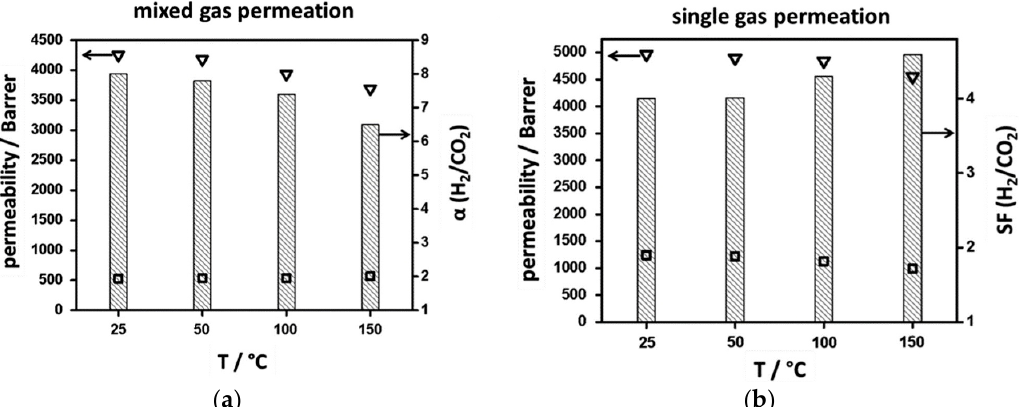
Figure 30. Mixed ( a ) and single gas permeabilities ( b ) for H 2 ( ∇ ) and CO 2 ( ⎕ ) and ideal/real separation factors (columns) for an equimolar mixture of H 2 /CO 2 at different temperatures for the neat supported NH 2 -MIL-125 membrane. (adapted with permission from ref. [130]).